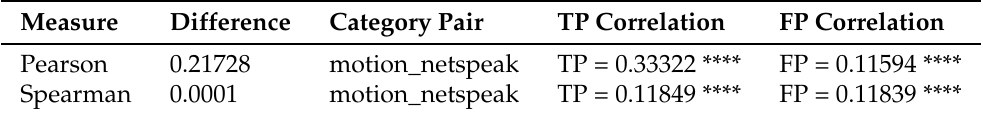
Table 11. Motion and Netspeak in Suicidal.